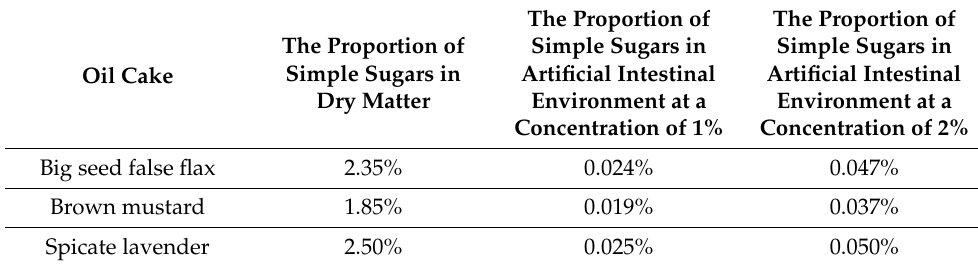
Table 4. Estimation of the amount of simple sugars in oil cake. The Proportion of The Proportion of Simple Sugars Simple Sugars in Oil Cake Dry Matter